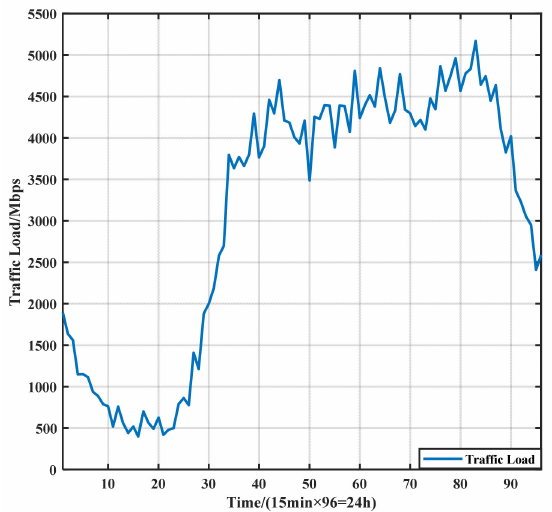
Figure A1. Traffic load of a 3 × 3 fifth generation mobile communications technology (5G) macro base station (BS) network.